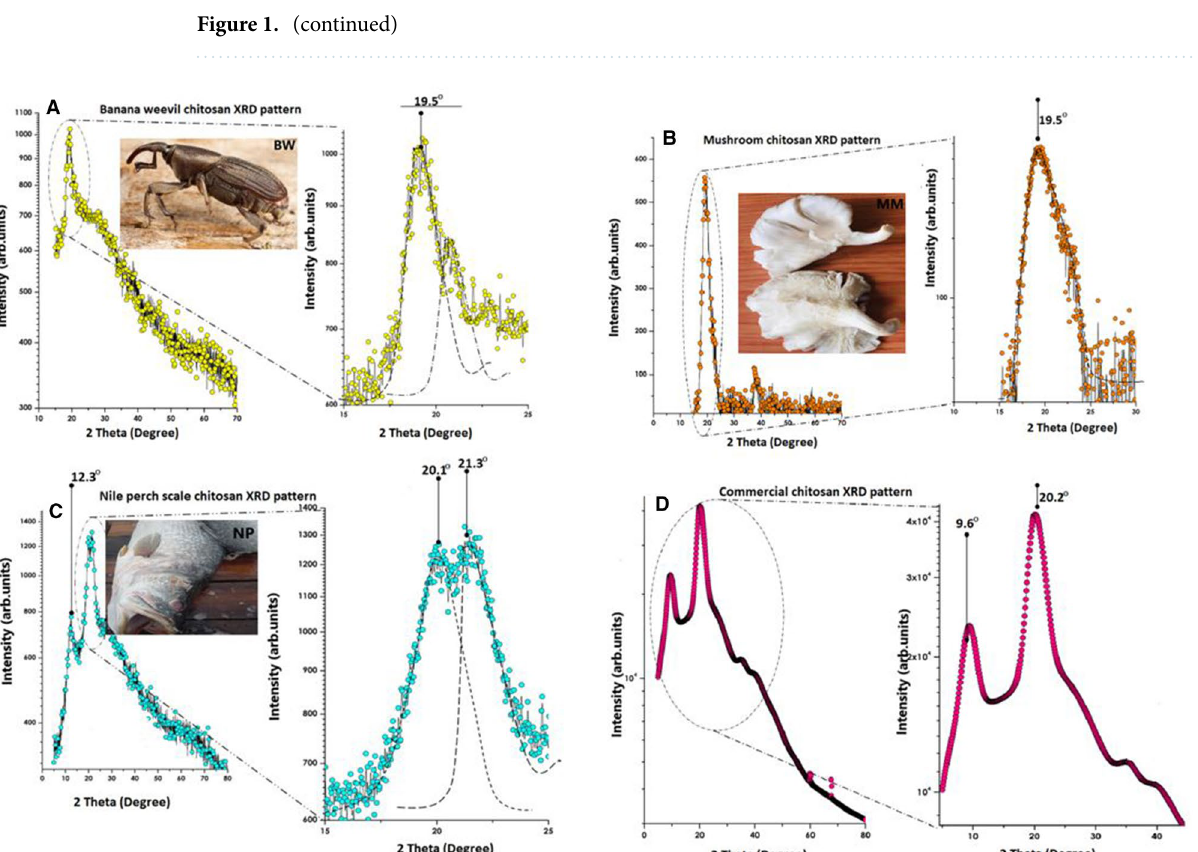
Figure 2. XRD patterns for chitosan isolated from locally available materials; ( A ) XRD pattern for banana weevil chitosan, ( B ) XRD pattern for mushroom chitosan, ( C ) XRD pattern for Nile perch scale chitosan, and ( D ) XRD pattern for commercial chitosan. Banana weevil (BW), mushroom (MM) and Nile perch (NP) pictures merged in XRD patterns ( A ), ( B ) and ( C ) were taken by author